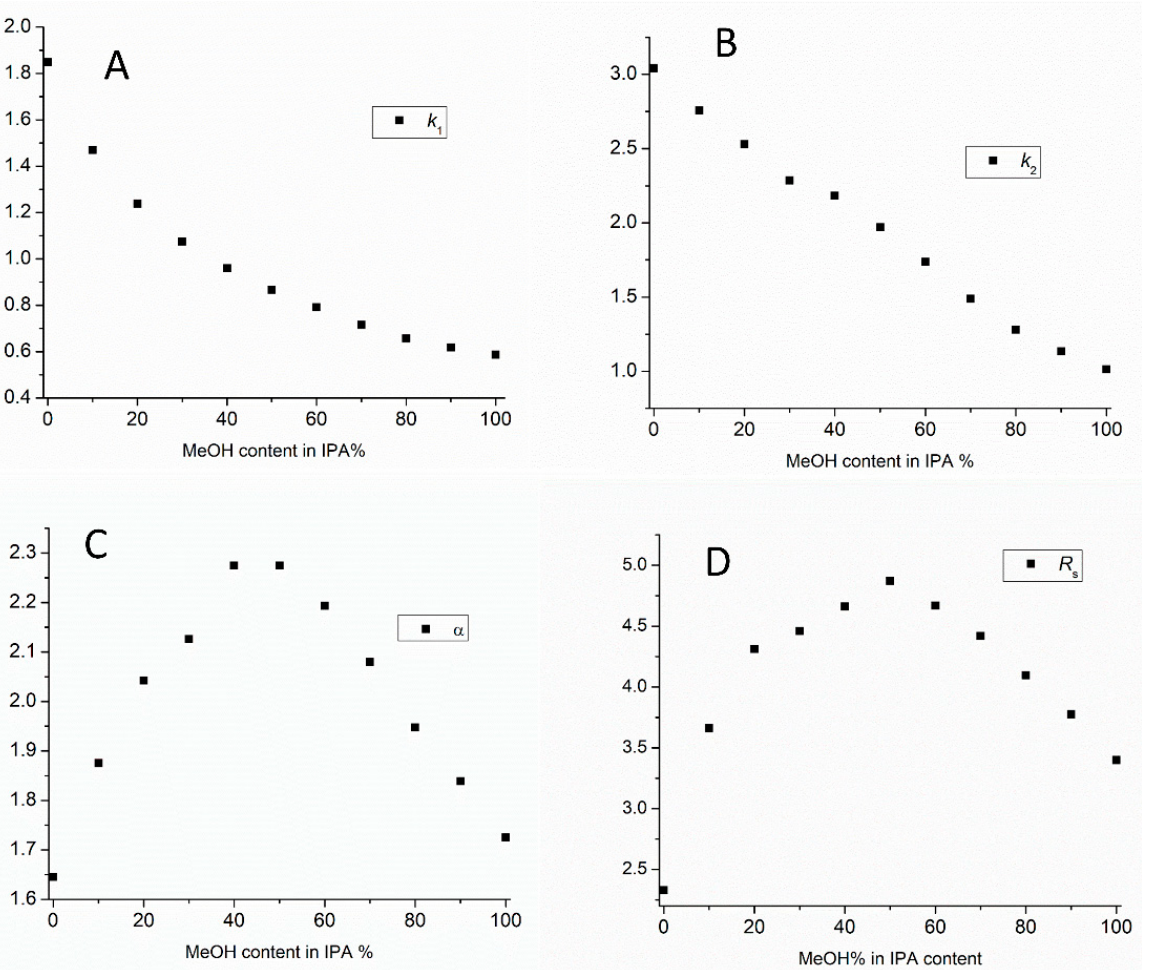
Figure 4. Plots of the retention factors (( A) : k 1 , ( B) : k 2 ), selectivity ( C ), and resolution factors ( D ) as a function of the MeOH content in IPA on Chiralcel OD column. (Chromatographic conditions: flow rate, 0.5 mL/min, column temperature 20 °C.).